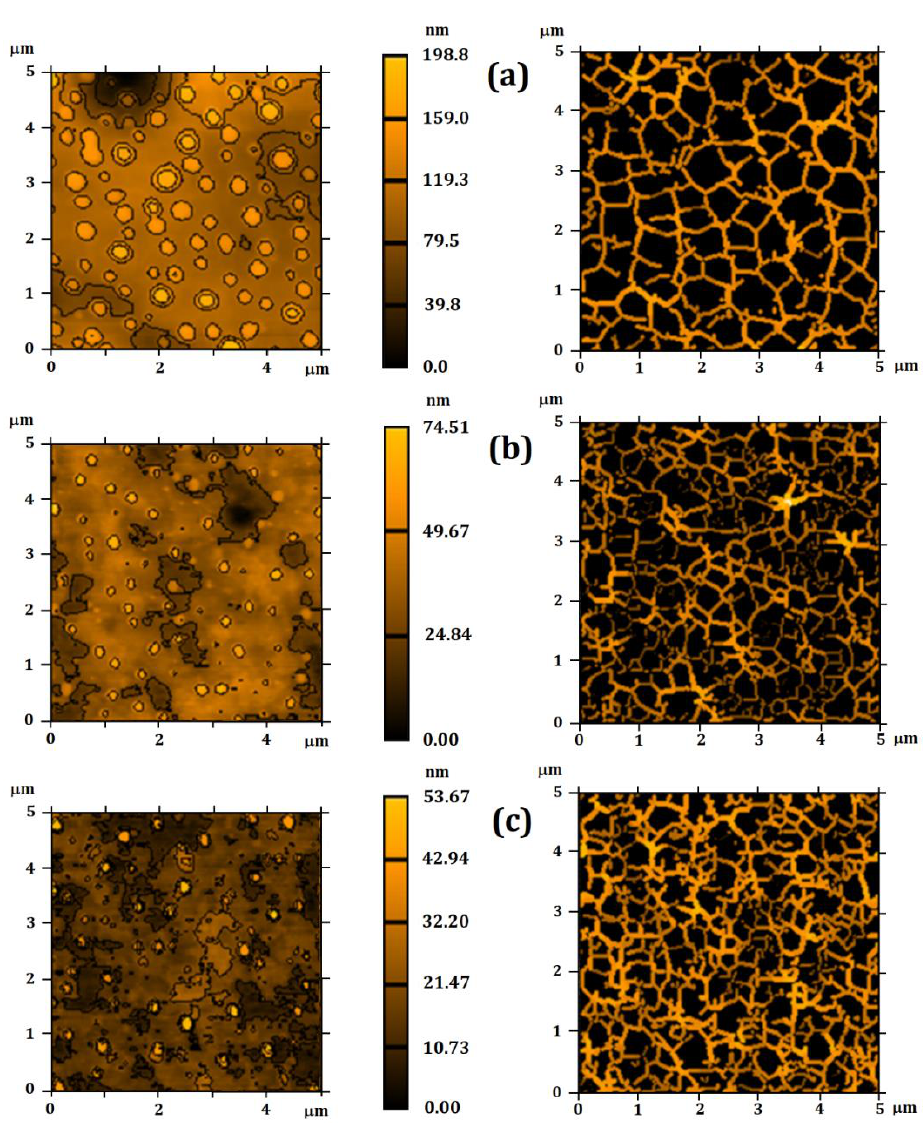
Figure 3. Renderings of the particle surface microtexture. Particles presented similar shapes in ( a ) P 0 , while ( b ) P 500 and ( c ) P 1000 acquired smaller and more randomized sizes. Table 3. Furrow parameters (maximum depth, mean depth, and mean density). Furrow Parameters